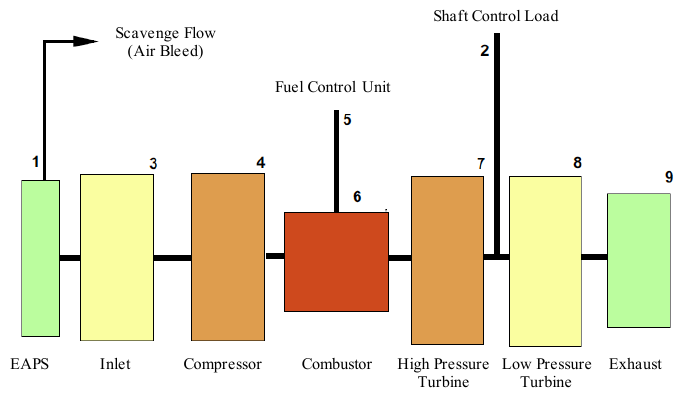
Figure 5. Turboshaft model for GSP.